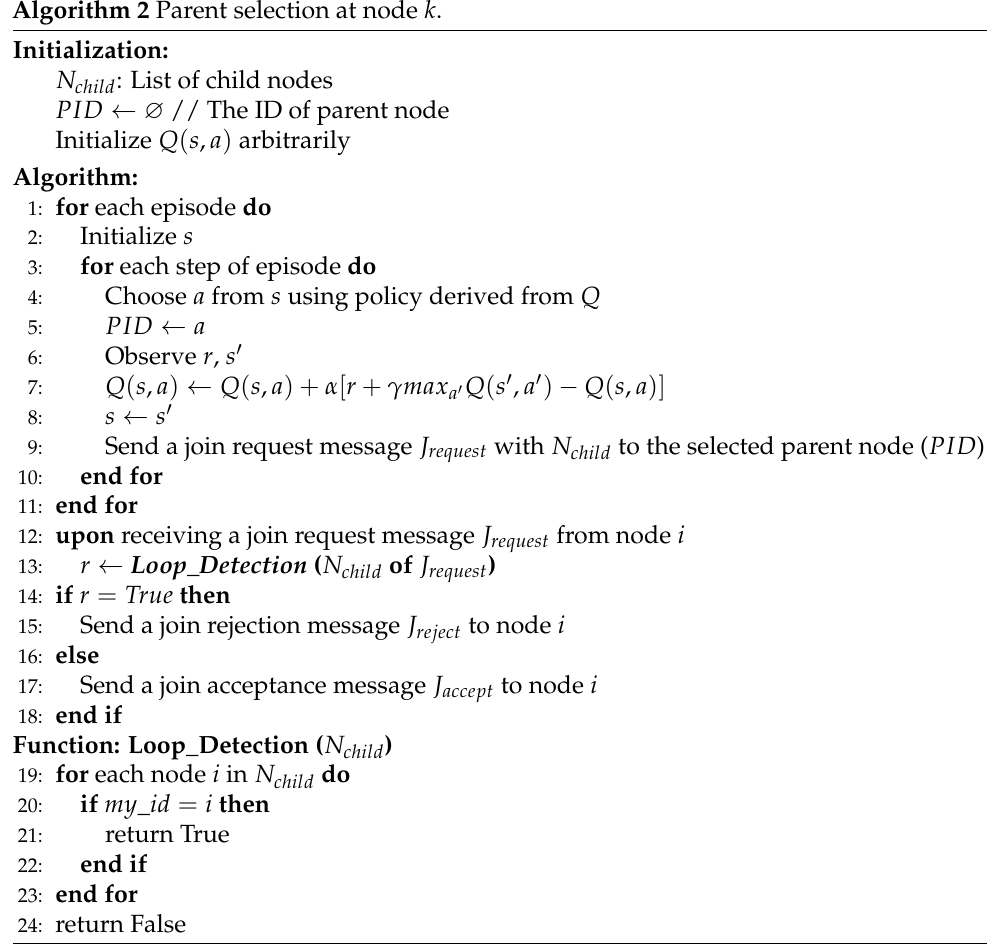
Algorithm 2 Parent selection at node k